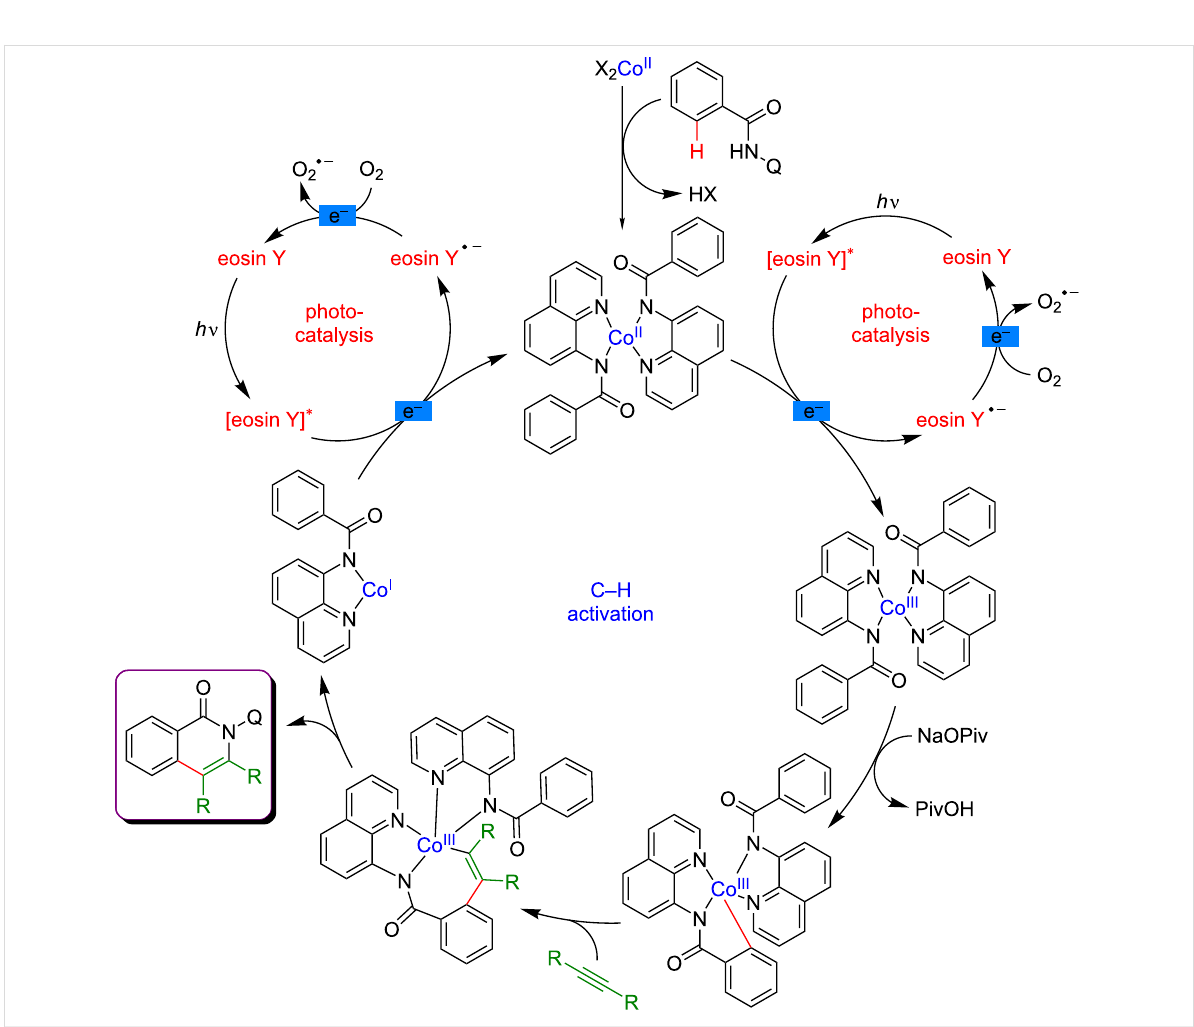
Figure 16: Proposed mechanism for the annulation of benzamides via dual